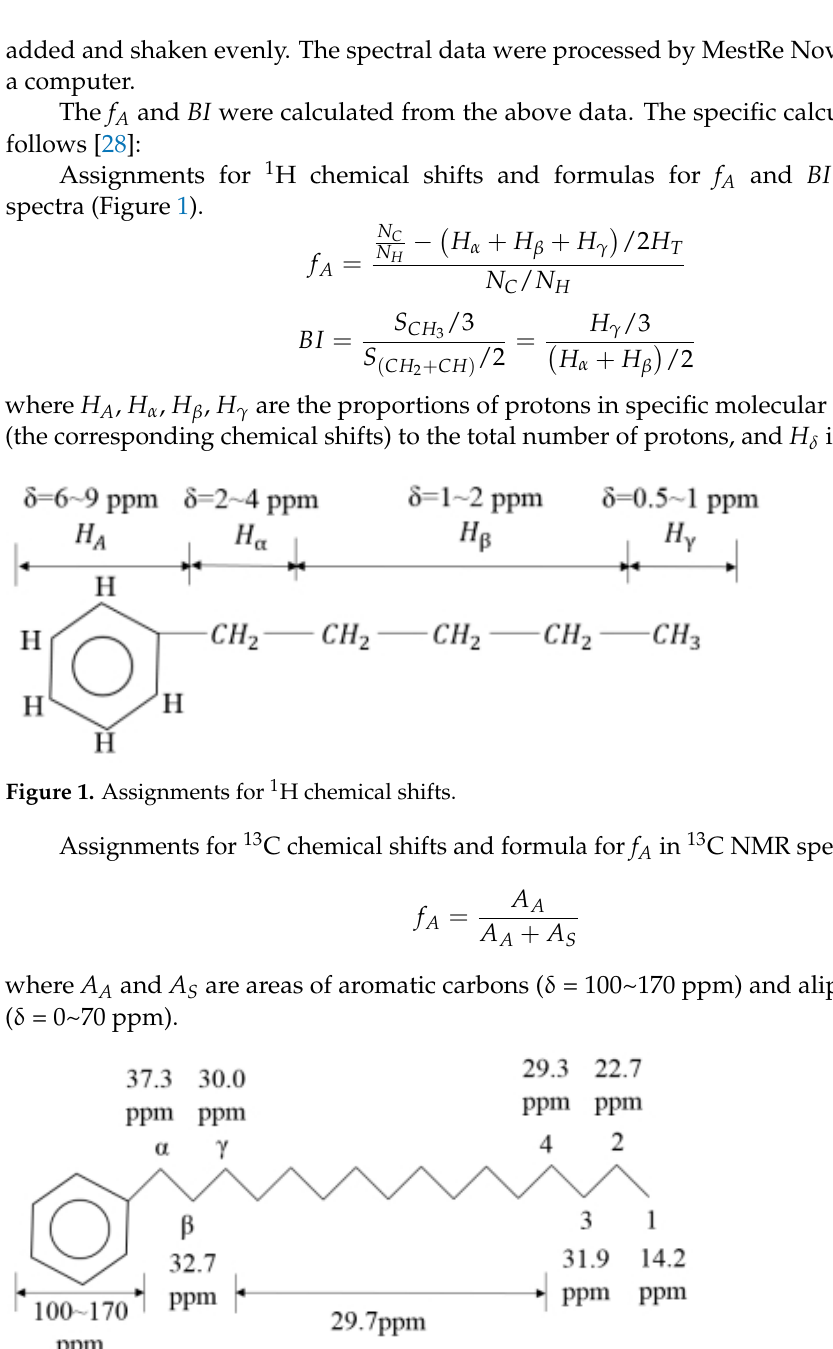
Figure 2. Assignments for 13 C chemical shifts.